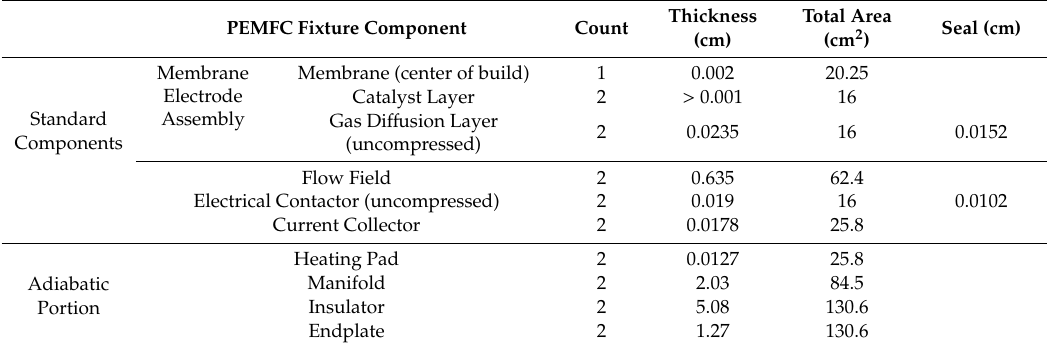
Table 4. Symmetric lay-up of quasi-adiabatic PEMFC fixture centered around the proton-conducting